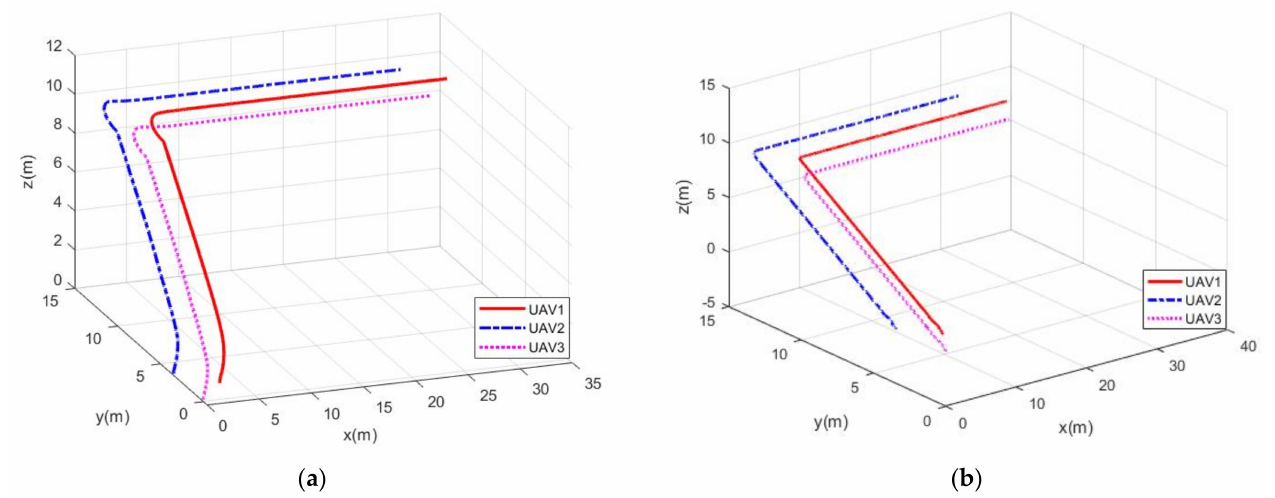
Figure 5. Trajectory tracking for UAVs with SMC ( a ) and MPC ( b ). The UAVs with IMPC ( b ) provide significantly better performance than SMC ( a ) at takeoff and corner